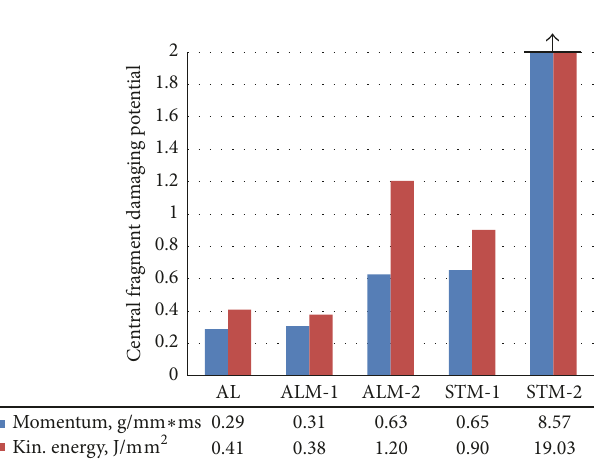
Figure 14: The damaging potential of the central fragments.